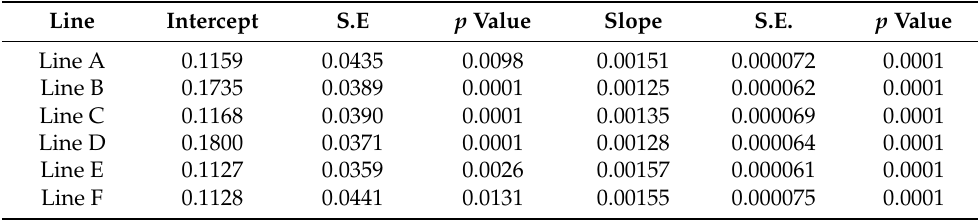
Figure 1. Tillering flow-chart for up to 42 days of growth in the growth room. These means (standard deviations in parenthesis) are the results of plants grown from seed of six half-sib lines harvested from three successive production years and grown for 21, 28, 35 or 42 days. (Note some plants were harvested that did not tiller, especially at the 21- and 28-day harvests). P refers to primary tillers (arising from the seminal vegetative axis), S for secondary, T for tertiary and Q for quaternary tillers. Table 5. Linear regression equations of leaf area on the main stem on square root of plant dry weight for six IWG lines including intercept, slope, their standard errors and p